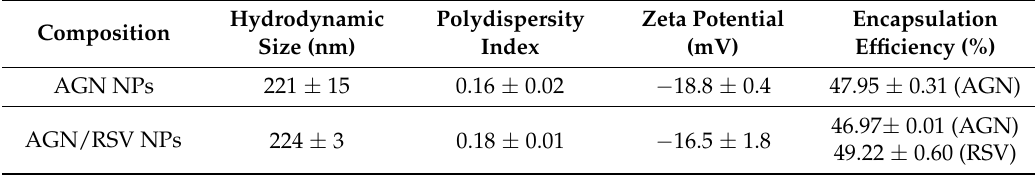
Table 1. The particle characterization of AGN NPs and AGN/RSV NPs (mean ± SD, n = 3).